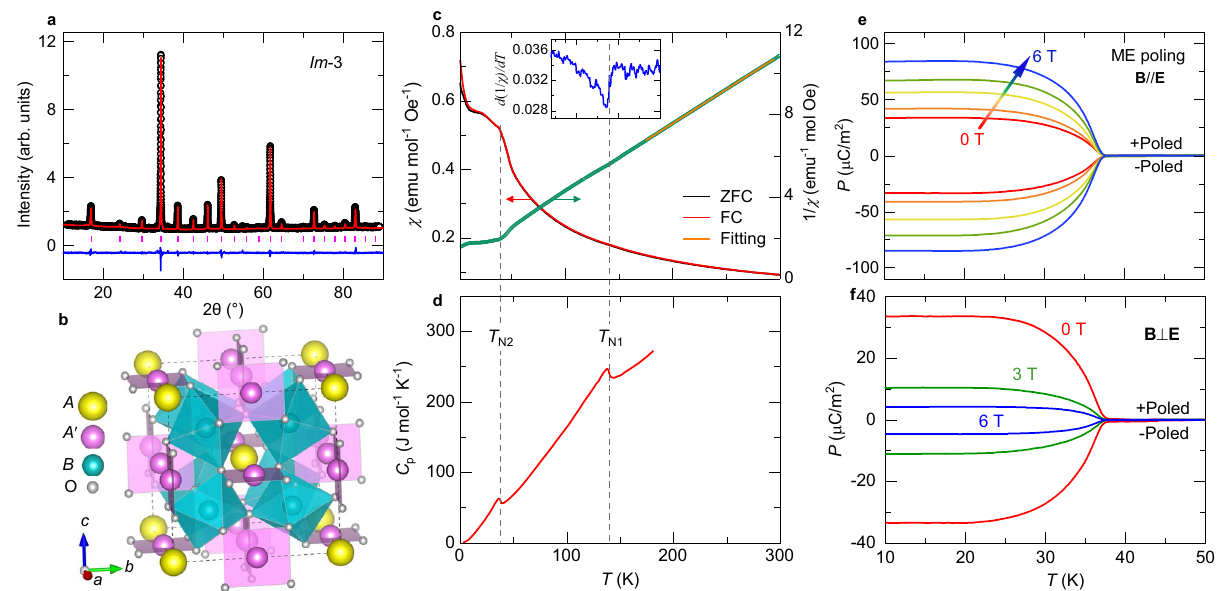
Fig. 2 Structure characterization, magnetic, speci fi c heat and polarization measurements for TMCO. a XRD pattern measured at room temperature and the Rietveld re fi nement results. The observed (black circles), calculated (red line), and difference (blue line) values are shown. The ticks indicate the allowed Bragg re fl ections with space group Im -3. b Crystal structure of A -site ordered perovskite AA ′ 3 B 4 O 12 with Im -3 symmetry. c Temperature dependence of magnetic susceptibility χ measured at 0.1 T and its inverse χ -1 . Both zero- fi eld-cooling (ZFC) and fi eld-cooling (FC) modes were adopted to measure χ . The yellow line shows the Curie – Weiss fi tting above 175 K. The fi tted effective moment μ eff (15.52 μ B f.u. -1 ) is comparable to the theoretical value (15.04 μ B f.u. -1 ) by considering the contribution from Tb 3 + , Mn 3 + and Cr 3 + ions. The inset shows the derivative of inverse susceptibility versus temperature. d Temperature dependence of speci fi c heat C p measured at zero fi eld. e , f Temperature dependent polarization P after poling the sample under an electric fi eld ( = E pole ) and different magnetic fi elds B , where B was not removed until the temperature increased to 50 K. For B // E and B ⊥ E con fi gurations, both + Poled and -Poled conditions were